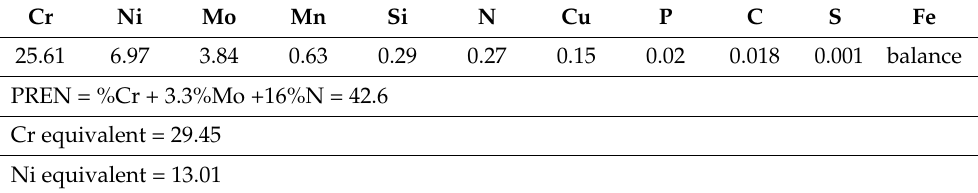
Table 1. Chemical composition of UNS S32750 SDSS (%wt.), Cr and Ni equivalent and PREN.